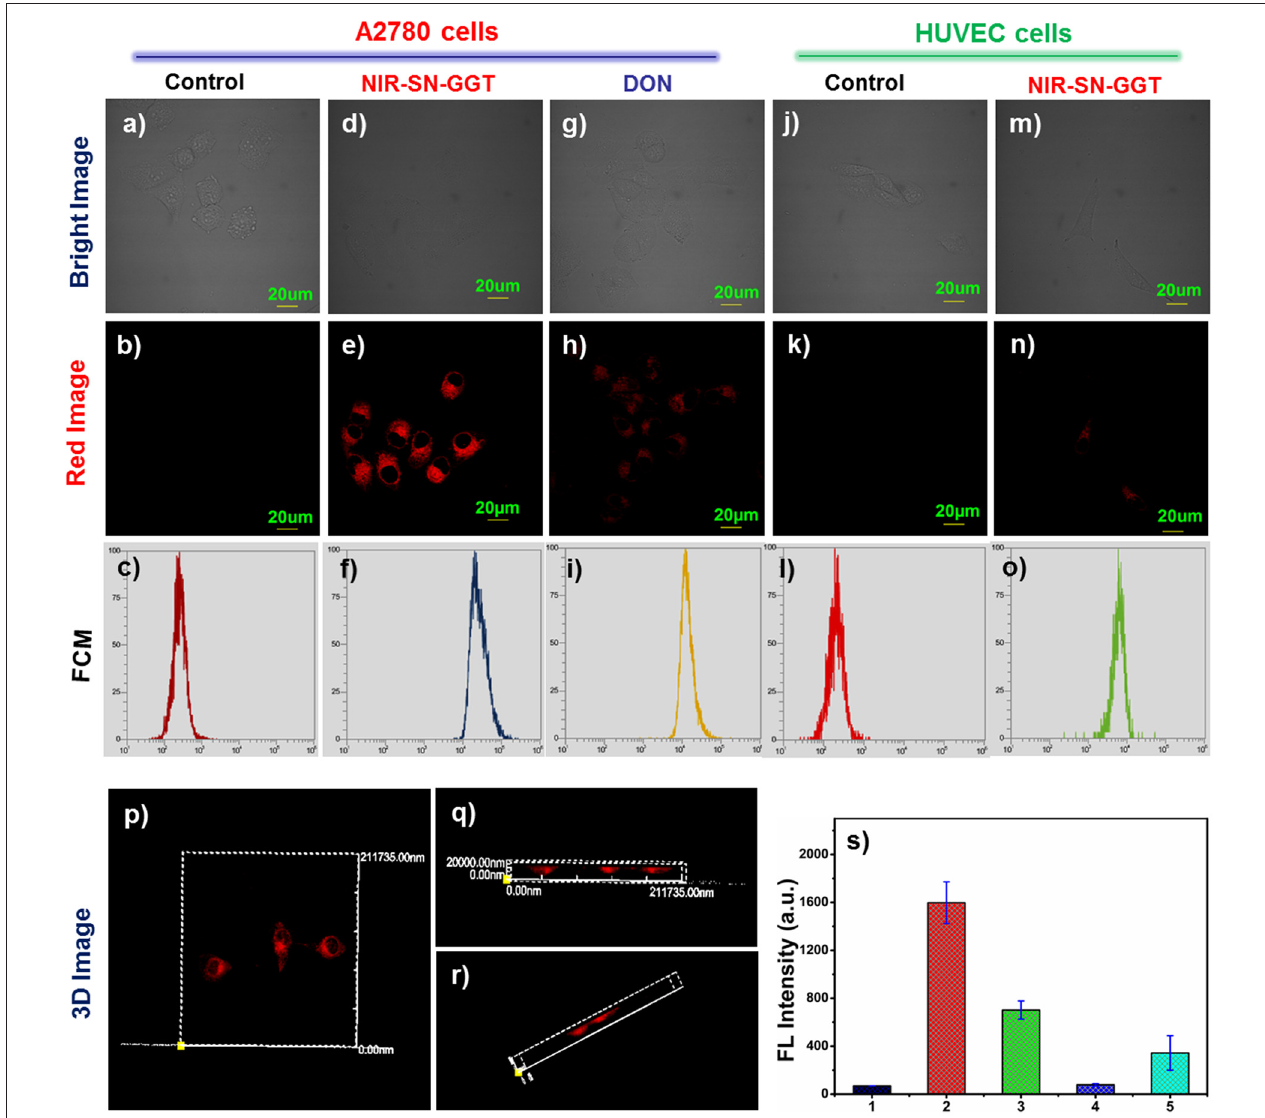
FIGURE 3 | Confocal fluorescence imaging of living cells. (a,b) A2780 cells; (d,e) A2780 cells incubated with 5 µ M probe NIR-SN-GGT; (g,h) A2780 cells pretreated with 30 µ M DON (inhibitor) and adding 5 µ M probe NIR-SN-GGT; (j,k) HUVEC cells; (m-n) HUVEC cells treated with 5 µ M probe NIR-SN-GGT; (c,f,i,l,o) represent the corresponding flow cytometry (FCM); (p,q,r) 3D fluorescence imaging of A2780 cells; (s) fluorescence emission intensities of red channel were measured as averages of 9 regions of interest (ROIs) from different treated cells ( b,e,h,k,n ). Error bar = RSD ( n = 9). λ ex = 488nm and λ em = 655–755nm. Scale bar = 20 µ m.